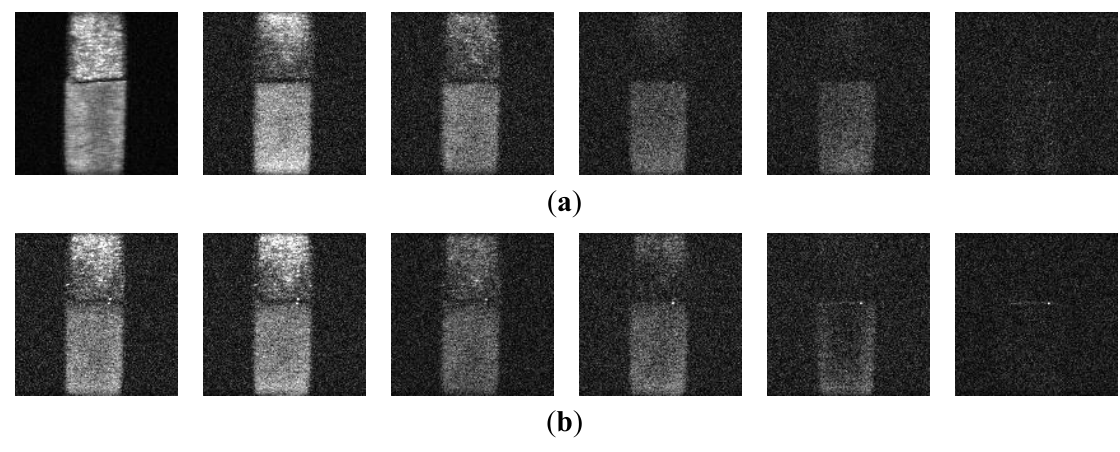
Figure 7. CO hydrate formation process in BZ-01 and BZ-02 using MRI: ( a ) the first 2 cycle; ( b ) the second